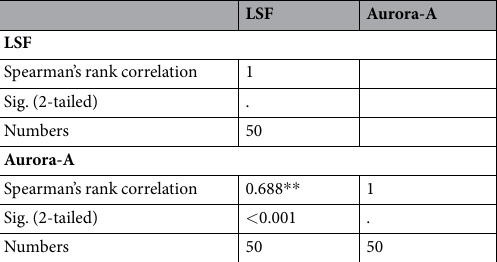
Table 1. The correlation between LSF, and Aurora-A expression in oral cancer specimens. * Statistically significant (p <